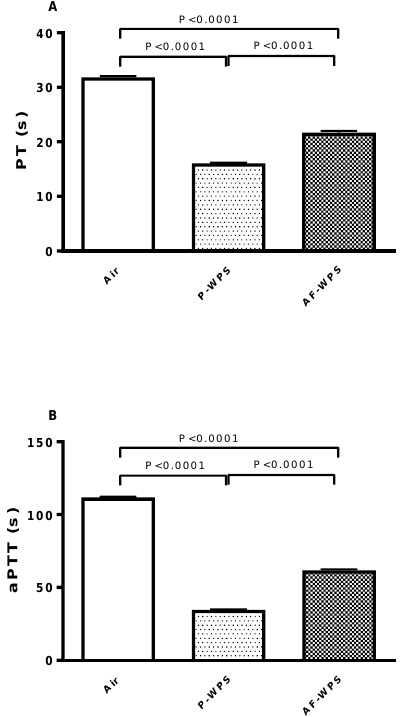
Figure 4. Effects of plain water-pipe smoke (P-WPS) or apple-flavoured (AF)-WPS on prothrombin time (PT, A) and activated partial thromboplastin time (aPTT) in vitro. PT ( A ) and aPTT ( B ) at the end of 1 mo exposure period to either air or P-WPS or AF-WPS. Data are mean ± SEM (n = 6); one-way ANOVA followed by Holm–Sidak’s multiple comparison